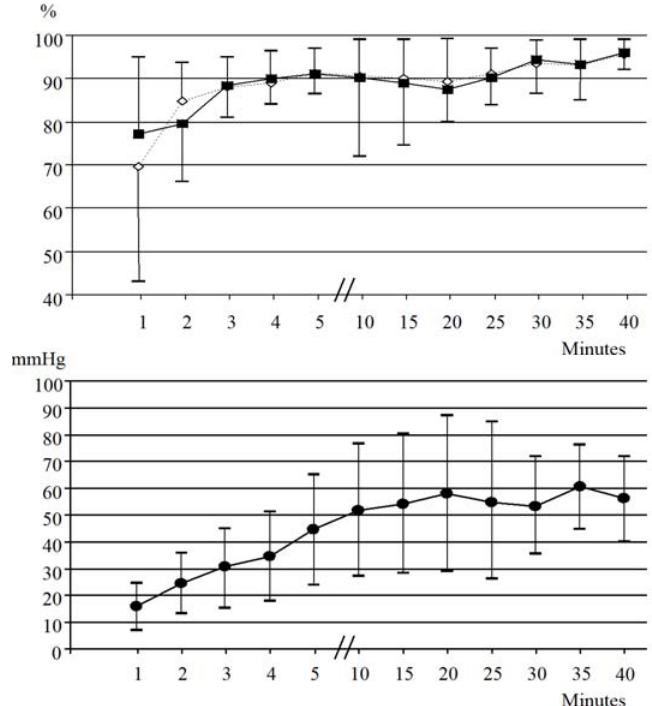
(white diamonds) and SpO 2MASIMO ( bottom ) during period 2TOSCA